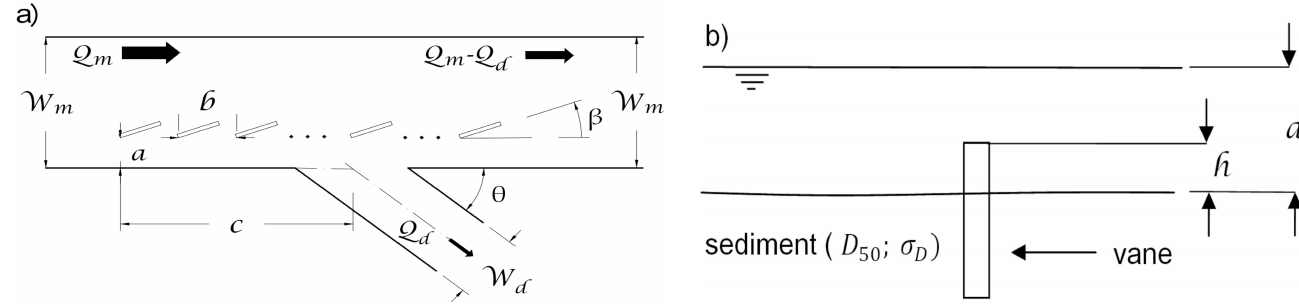
Figure 1. Lateral diversion: ( a ) plan view. ( b ) vane